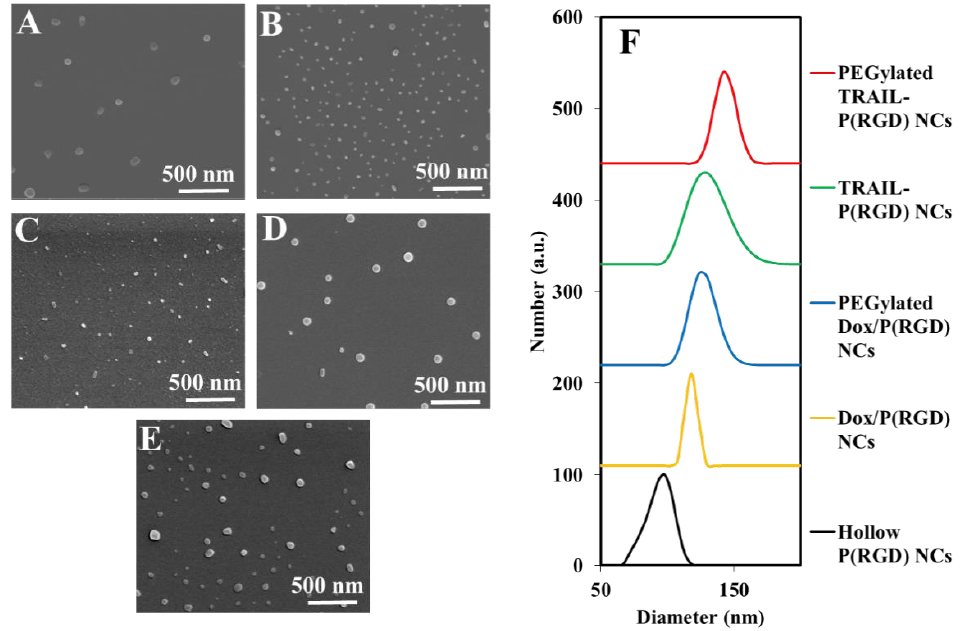
Figure 2. SEM images of P(RGD) NCs. ( A ) Hollow, ( B ) PEGylated Dox-loaded, ( C ) Dox-loaded, ( D ) PEGylated TRAIL-conjugated, and ( E ) TRAIL-conjugated NCs. ( F ) Diameter distributions measured by DLS.